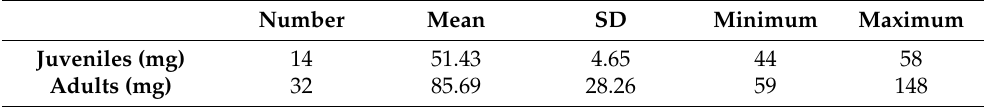
Table 3. ELW associated with age categorization using the ELW-cutoff